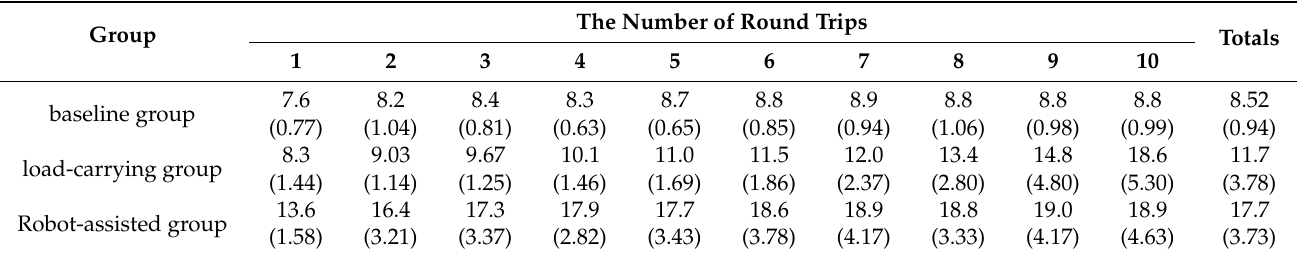
Table 2. Descriptive statistics: mean and standard deviation (SD) values of lap times.